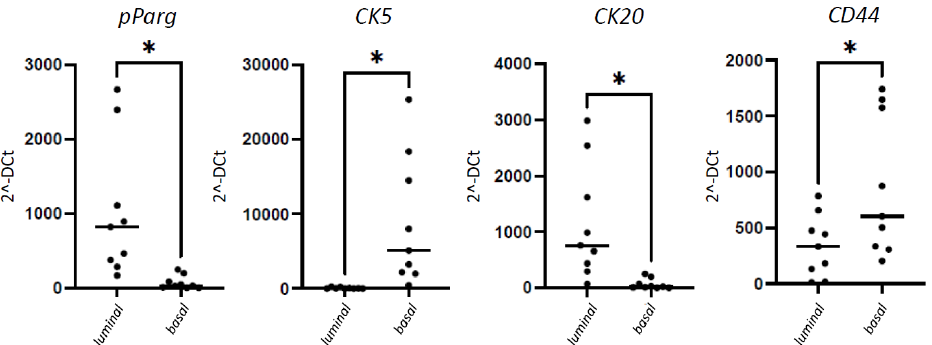
Figure 3. Gene expression of UC markers. Quantification of pPAR γ , CK5, CK20, and CD44 gene expression in tissue specimens from 18 patients (black dots) with UC following RT-PCR analysis. mRNA expression for each gene is normalized to GAPDH. Total of 9 luminal vs. 9 basal UC subtypes: pPAR γ * p = 0.014; CK20 * p = 0.0130; CK5 * p = 0.0167; CD44 * p = 0.0404.